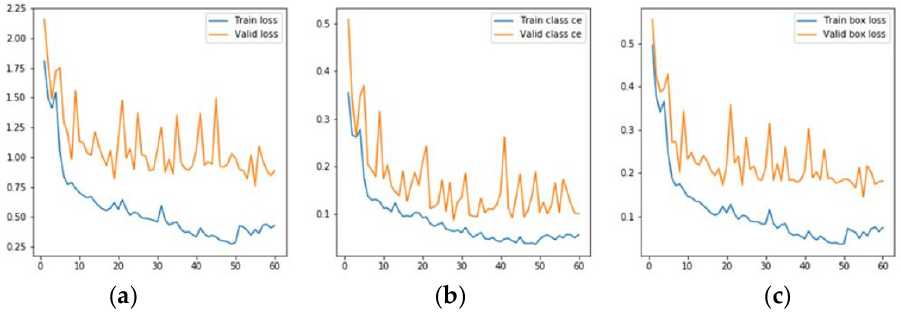
Figure 7. ( a ) total loss; ( b ) class and ( c ) BBox loss of the